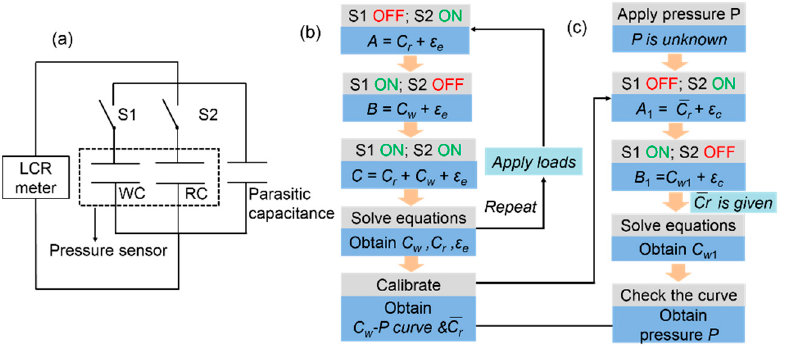
Figure 7. Control scheme to reduce parasitic capacitance. ( a ) Equivalent circuit of the control scheme; ( b ) flowcharts of the calibration process; ( c ) flowcharts of the measuring process.